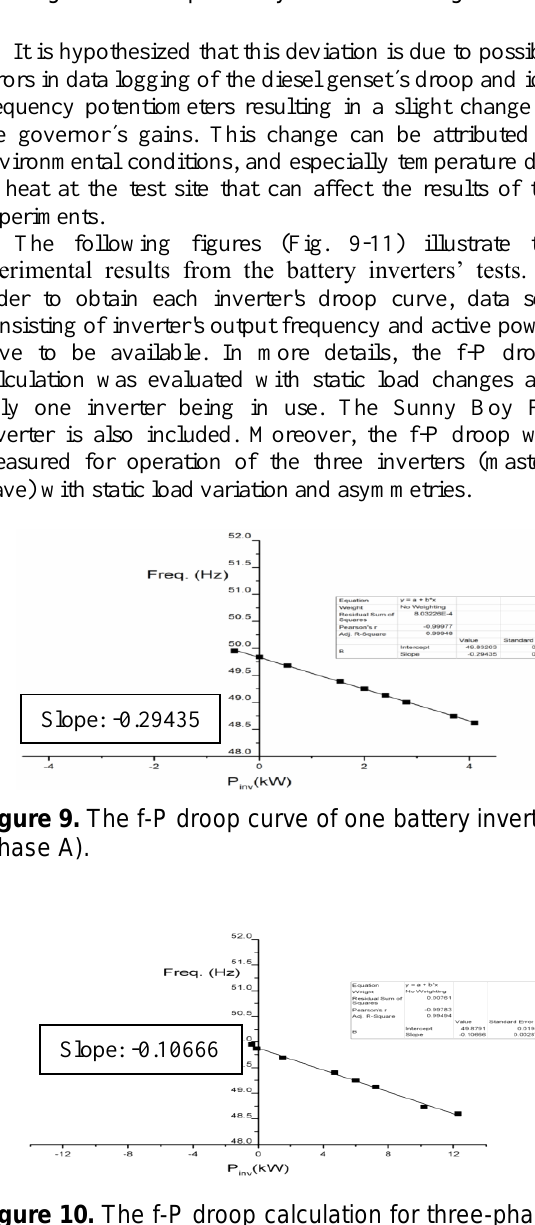
Figure 10. The f-P droop calculation for three-phase